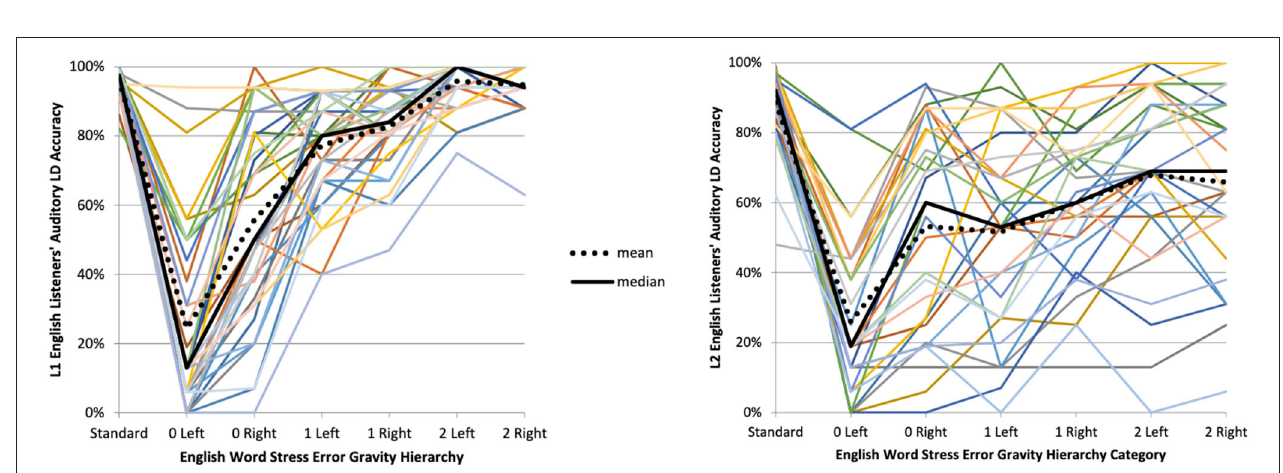
FIGURE 3 | Median accurate auditory LDRT for L2 English listeners with 2 + accurate LDs per Hierarchy category ( n = 23).